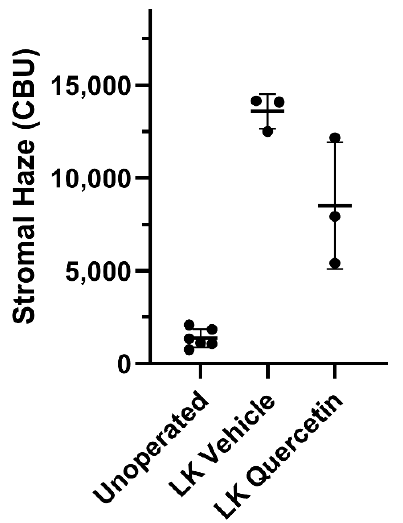
Figure 4. Rabbit CMTF haze assessment. Representative in vivo confocal microscopy through fo- cusing (CMTF) scans and 3D reconstructions from rabbits treated with vehicle ( left ) or quercetin ( right ), 21 days after LKsurgery. The arrows denote the region of the highest haze detected within the corneal stroma.